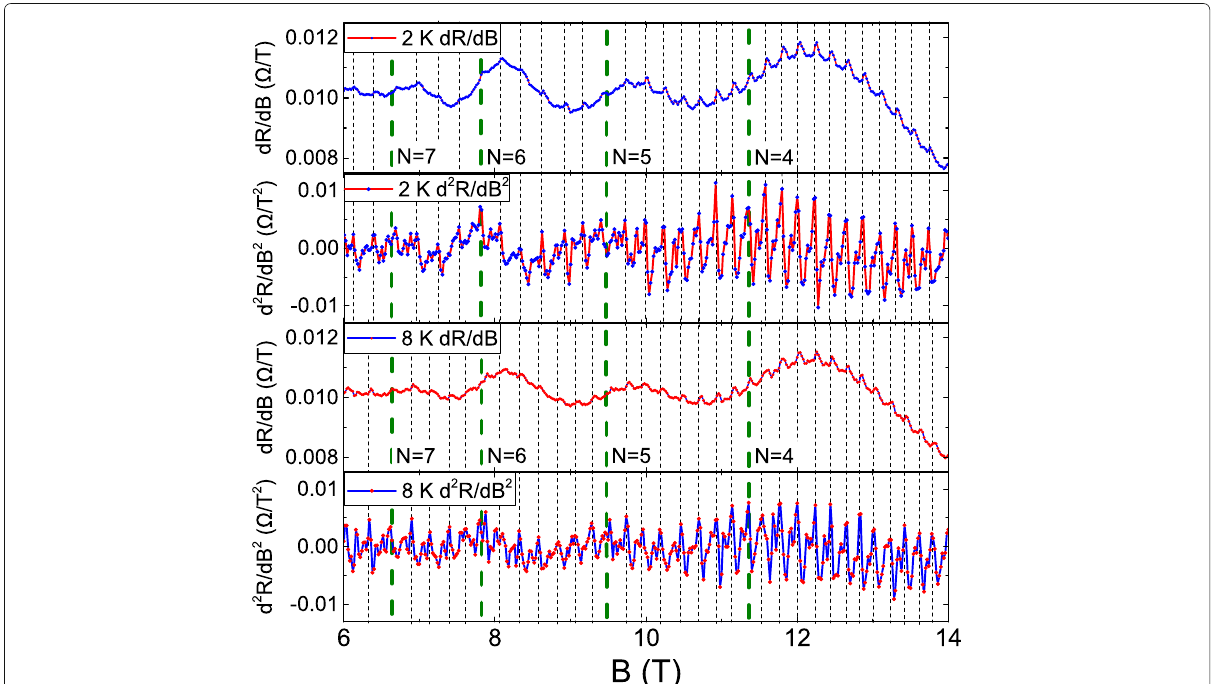
Fig. 2 The dR / dB and d 2 R / dB 2 as a function of B at 2 and 8 K. It shows periodic oscillations and the oscillation period is Landau level dependence